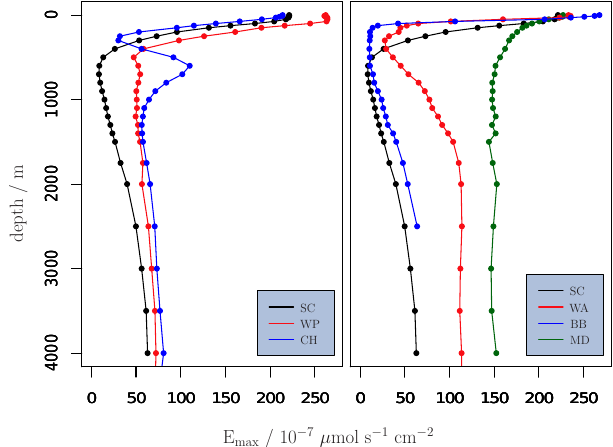
It can be shown for the range of u 100 values in the mid- approximately a doubling of C f (i.e. C f is roughly propor- tional to the inverse of u 100 ). The nonlinear character of